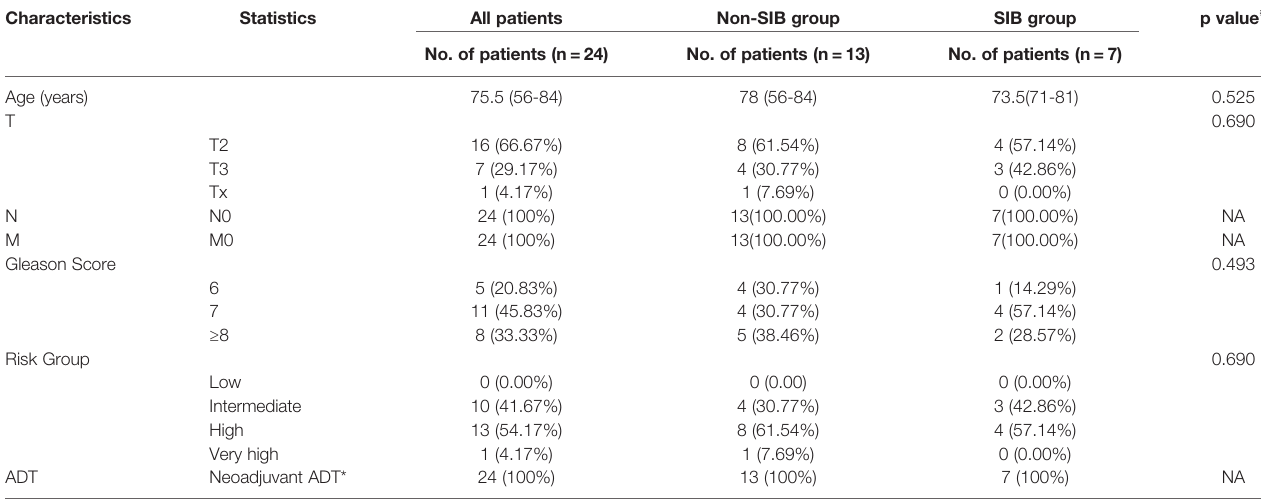
TABLE 1 | Patients ’ demographic and clinical